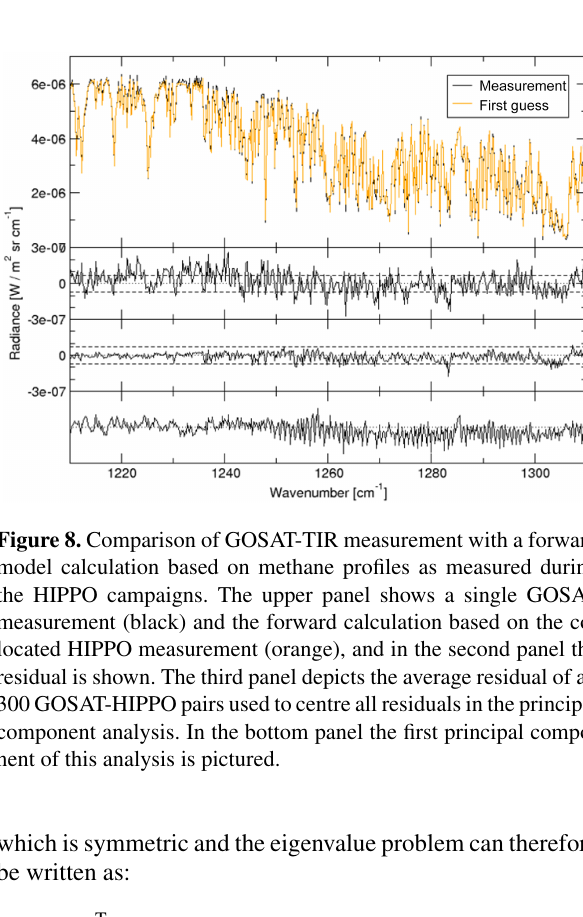
Figure 7. Bar chart of the methane profile bias over ten different TCCON stations listed in Table 1, with the MACC/TCCON profiles as reference. The data are divided for different scenes; land and ocean scenes during daytime (orange and cyan, respectively) and nighttime (black and blue, respectively). In (a) the deviation is shown for an altitude of ≈ 2km and in (b) of ≈ 9km.